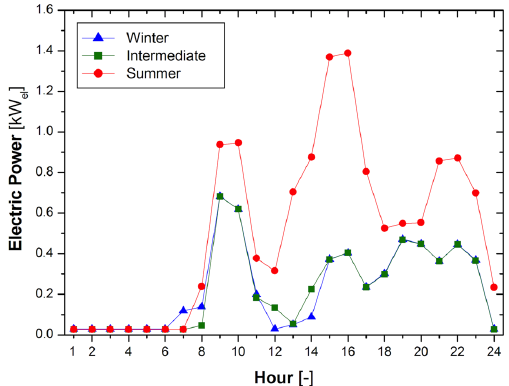
Figure 11. Typical electric load profiles for a single apartment in the investigated area during winter, intermediate, and summer season.